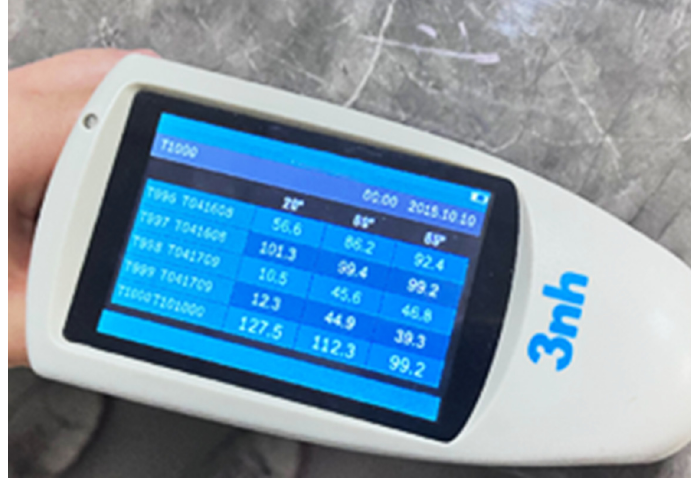
Figure 4. Material surface gloss test.